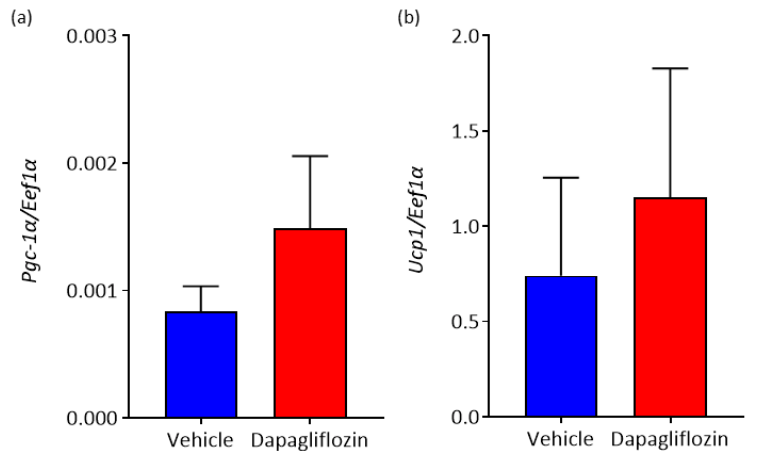
Figure 5. Inhibition of SGLT2 promotes elevation of markers of BAT in WAT. ( a ) Pgc-1a mRNA expression and ( b ) Ucp1 mRNA expression; n = 7–8 mice/group. All data are presented as mean ± SEM.